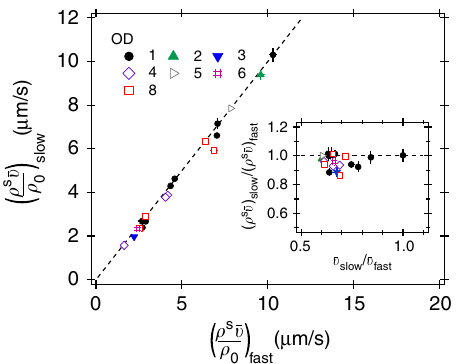
Fig. 4 ρ s (cid:1) v either side of an intensity step for various sample densities and speed ratios. The main plot shows ρ s (cid:1) v for the fi rst tile on the slow ( – ) side vs. the same quantity for the fi rst tile on the fast ( + ) side for several independent datasets. For both low density ( fi lled symbols) as well as higher-density datasets (open symbols) Eq. (6) holds. This is also demonstrated in the inset, which shows ( ρ s (cid:2) (cid:1) v (cid:2) /( ρ s þ (cid:1) v þ ) vs. (cid:1) v (cid:2) / (cid:1) v þ for the same datasets. Error bars show